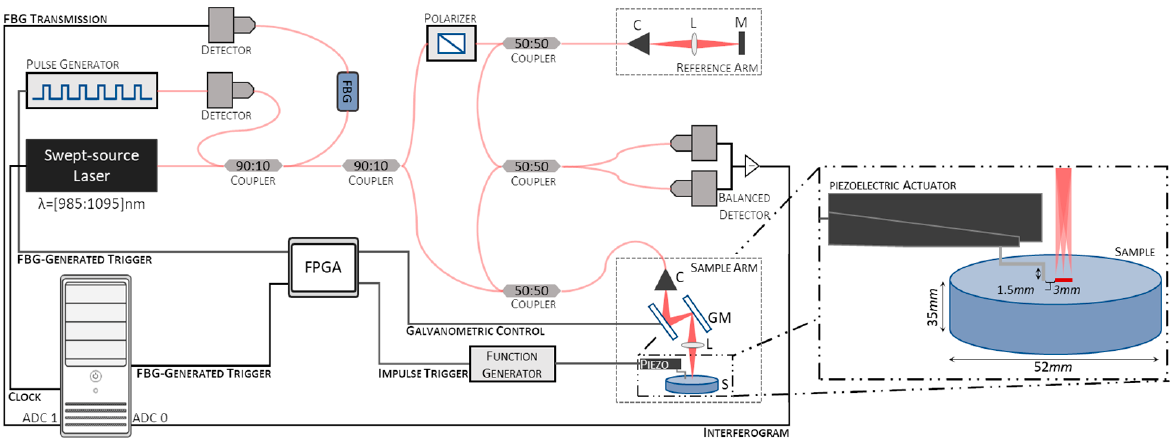
Figure 1. Schematic representation of the system used for the swept-source optical coherence elas- tography (SS-OCE) system employed. C—Collimator, L—Lens, M—Mirror, GM—Galvanometric mirrors, ADC—Analog-to-digital converter channel.